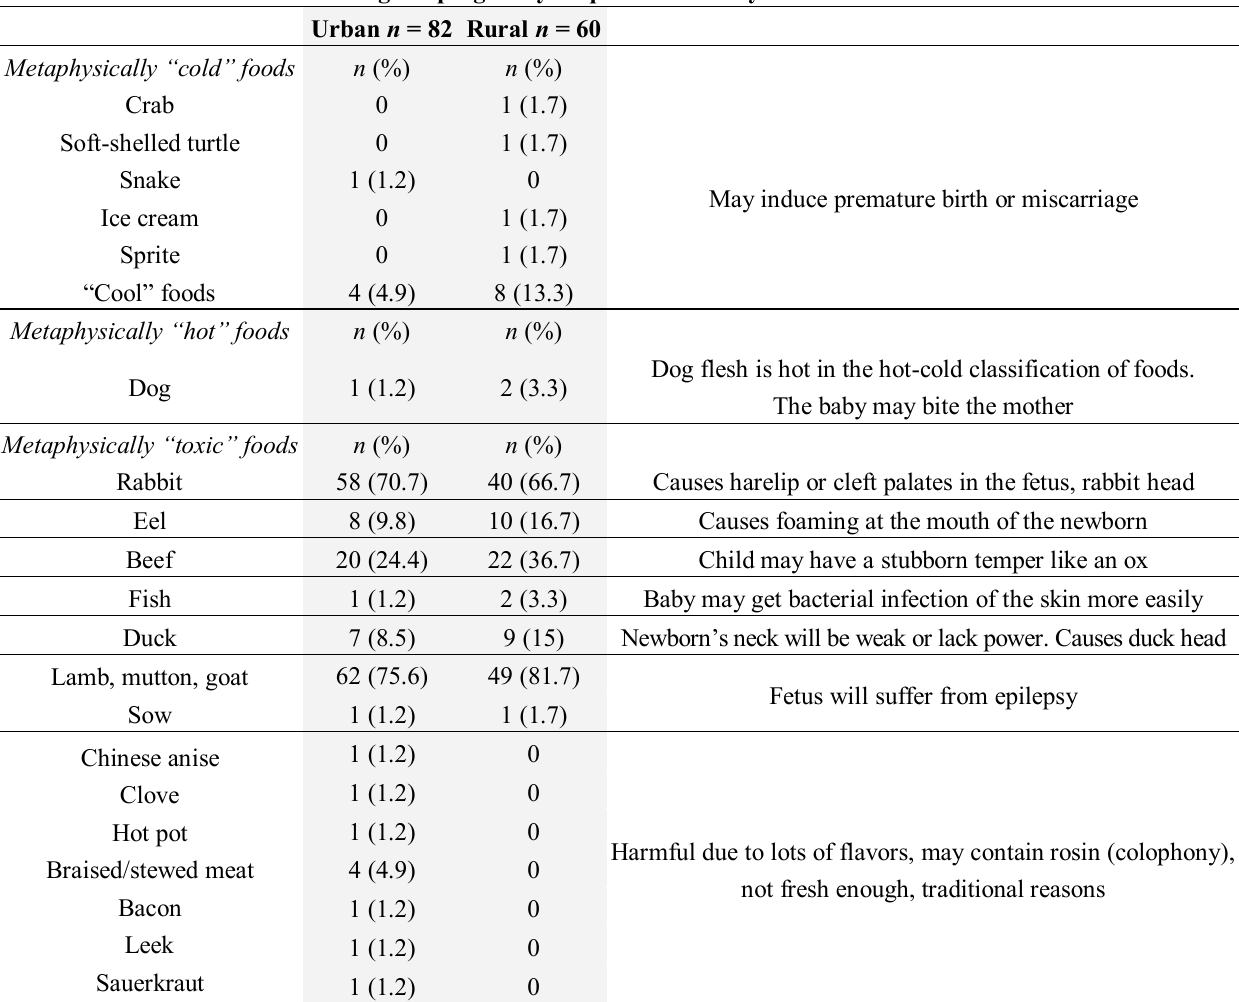
Table 1. Stated reasons for practicing special dietary precautions during pregnancy among women who adhered to any food taboos ( n =